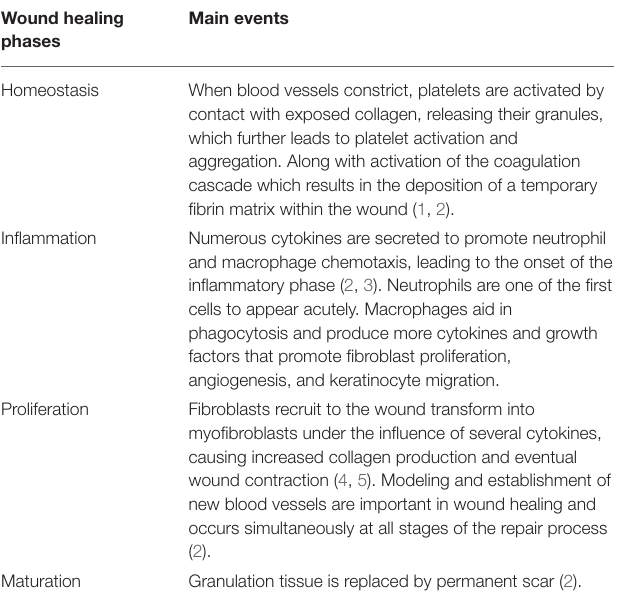
TABLE 1 | Wound healing phases. Wound healing phases